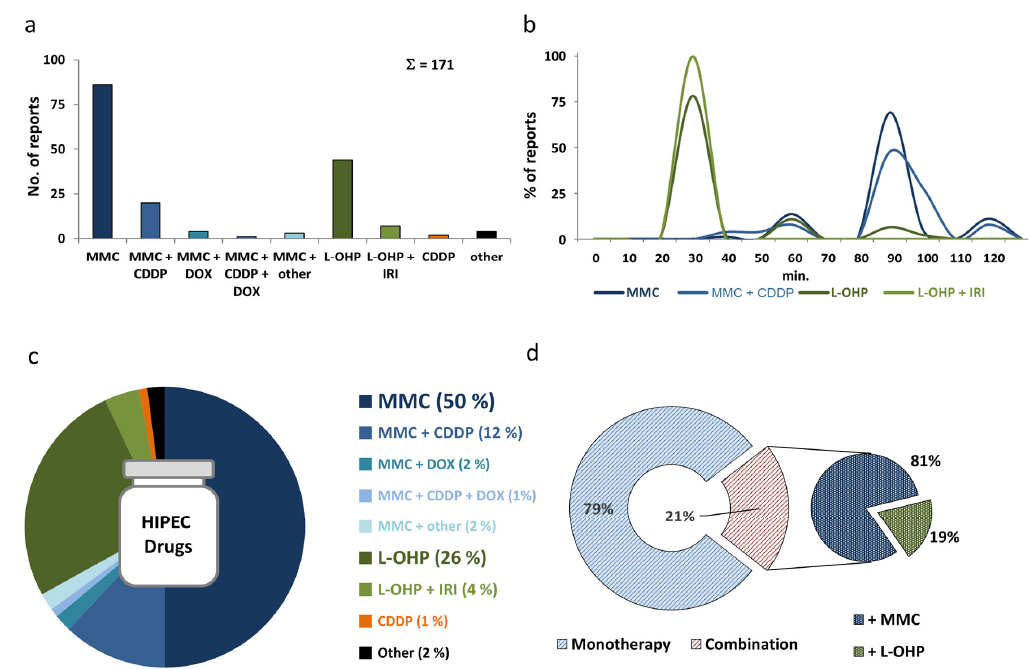
Figure 2. Drug use: ( a ) Bar chart of HIPEC (hyperthermic intraperitoneal chemotherapy) reports ( n = 171) with respective drugs or drug combinations. ( b ) Percentages of included reports on selected drugs and drug combinations plotted against HIPEC duration in minutes (x-axis). ( c ) Percentages of drugs and drug combinations among reports. ( d ) Percentages of drug mono- and combination therapies. Drug combinations were further subdivided into protocols using a drug combination with MMC or L-OHP. Abbreviations used: CDDP (cisplatin); DOX (doxorubicin); IRI (irinotecan); L-OHP (oxaliplatin); and MMC (mitomycin c).